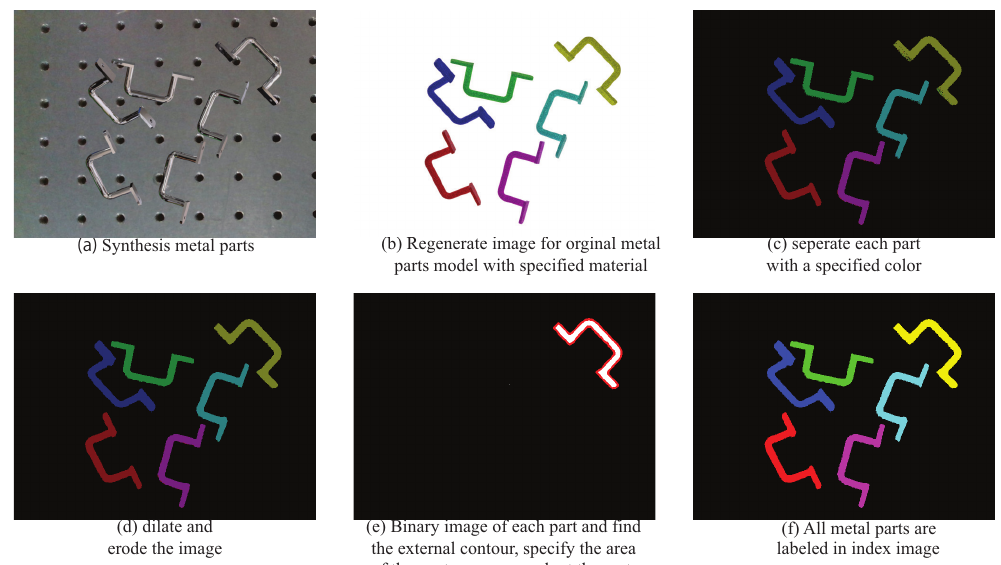
Figure 4. The procedure of annotating pixel-wise labels, mainly containing six stages.